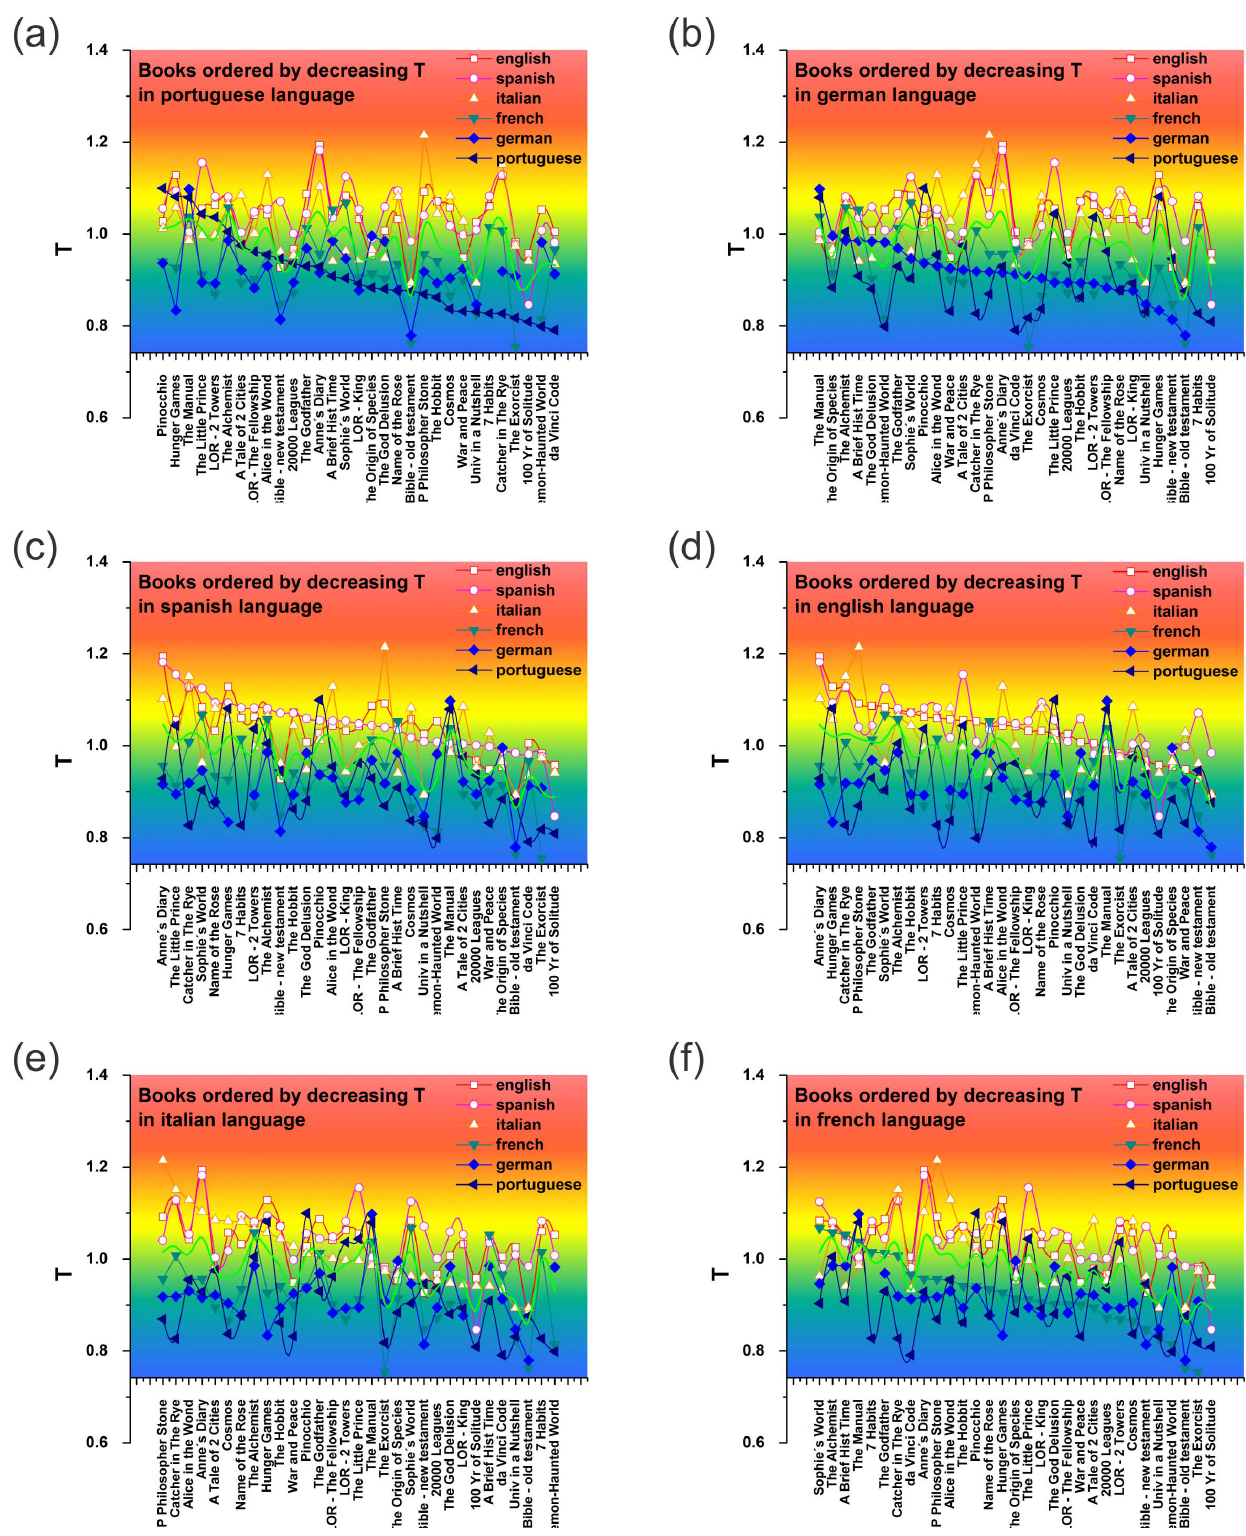
Figure 4. Language dependence of the temperature in the vocabulary of a book. Plots of the characteristic temperature for the vocabulary of books by increasing order in six different languages: (a) Portuguese, (b) German, (c) Spanish, (d) English, (e) Italian and (f) French.